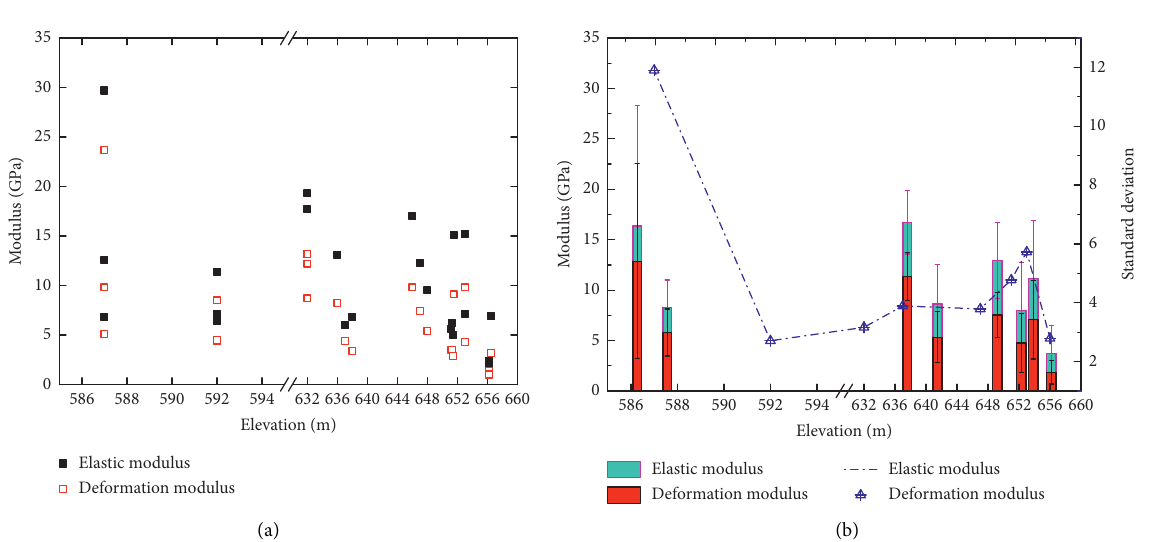
Figure 7: Diagram of Elastic modulus and deformation modulus varying with elevation: (a) data points’ distribution of elastic modulus and deformation modulus in different elevation; (b) mean value and standard deviation of elastic modulus and deformation